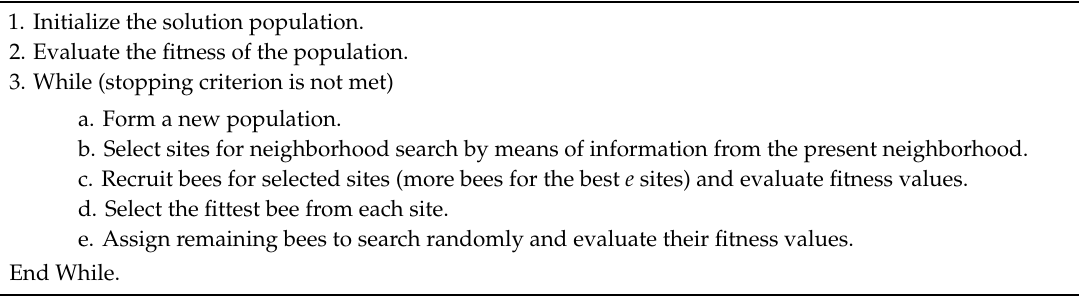
Table 4. The basic steps of the artificial bee colony clustering